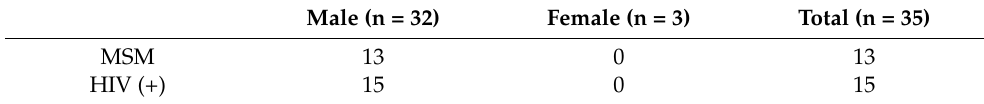
Table 1. Distribution of patients based on sex, sexual preferences and presence of HIV infection.